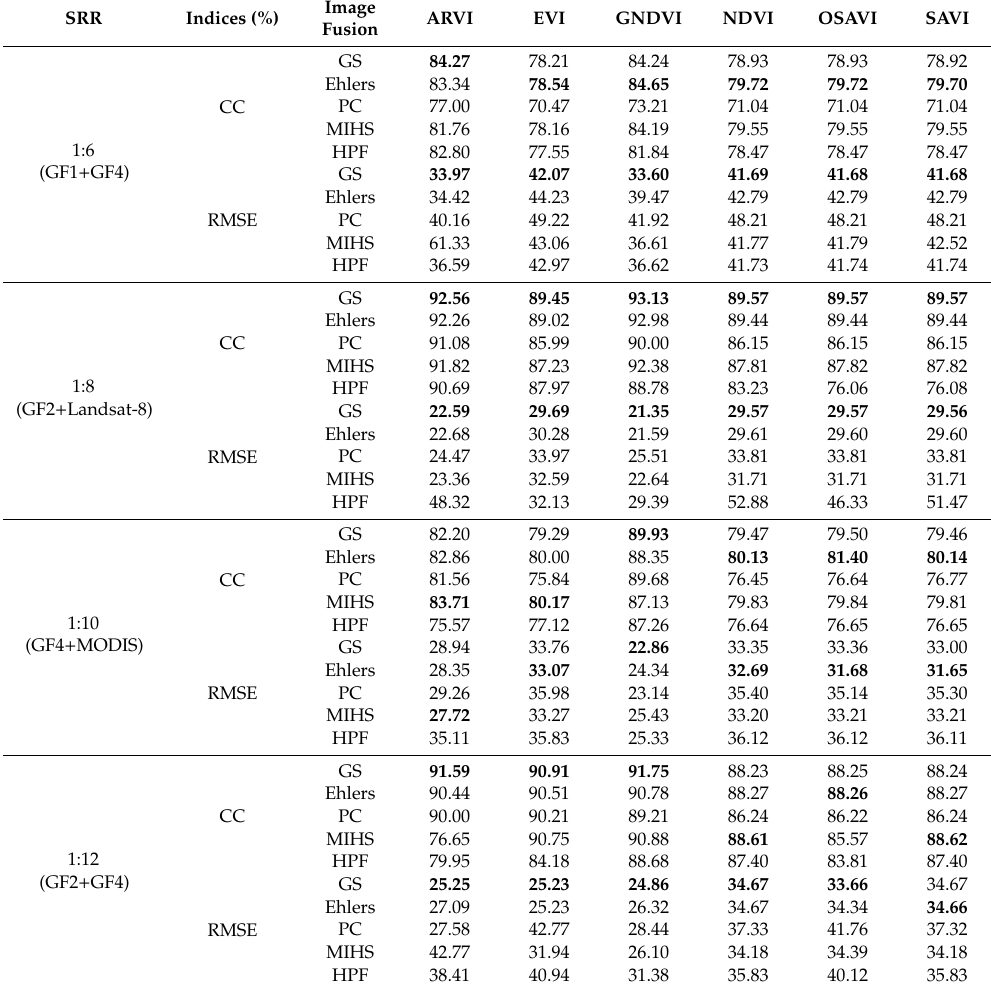
Table 6. Quality of FVI result in multi-sensor fusion (values in bold font indicate good quality). Image SRR Indices (%)